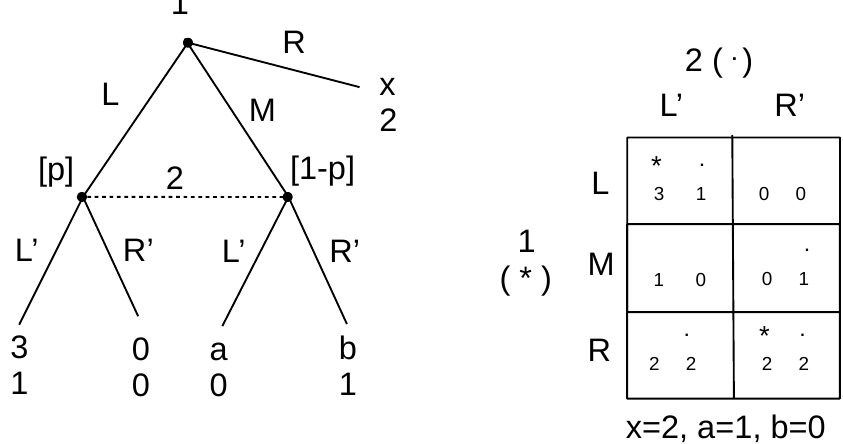
Figure 3. Game with variable outside